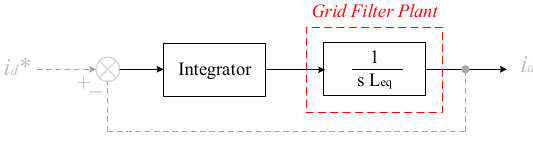
Figure 15. Step 1 of the loop-shape design technique.